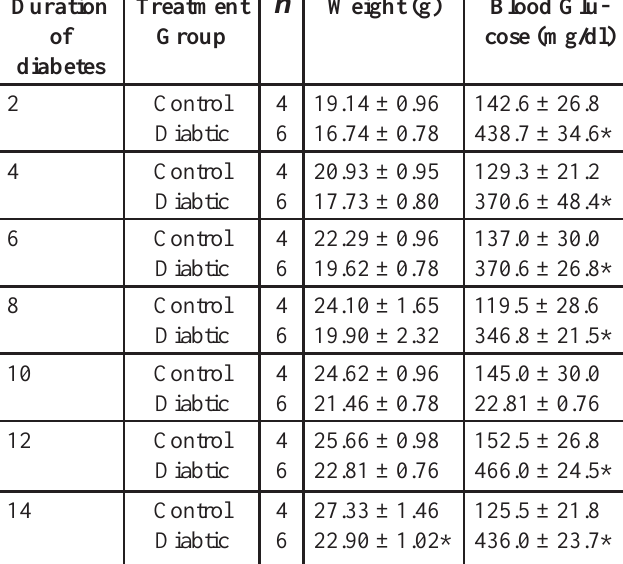
Table 2: Average weights and blood glucose levels of control and diabetic mice. The normal range (mg/dl) for blood glucose level is between 126.5 ± 12.6 and 140.2 ± 26.6. Data were pre- sented as the mean ±SEM. *Significantly different from age- matched control mice ( p <